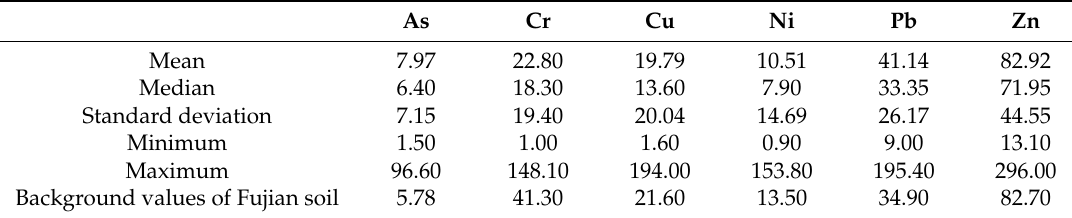
Table 1. Descriptive statistics of trace metals in the soils of the Golden Triangle (mg · kg − 1 ).